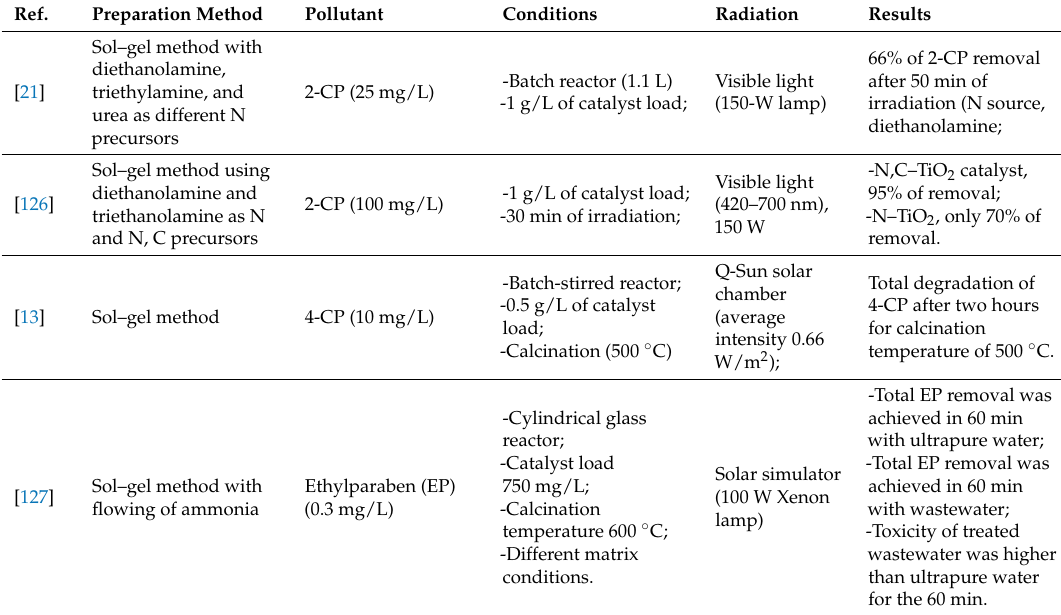
Table 3. Emerging contaminants degradation through photocatalytic